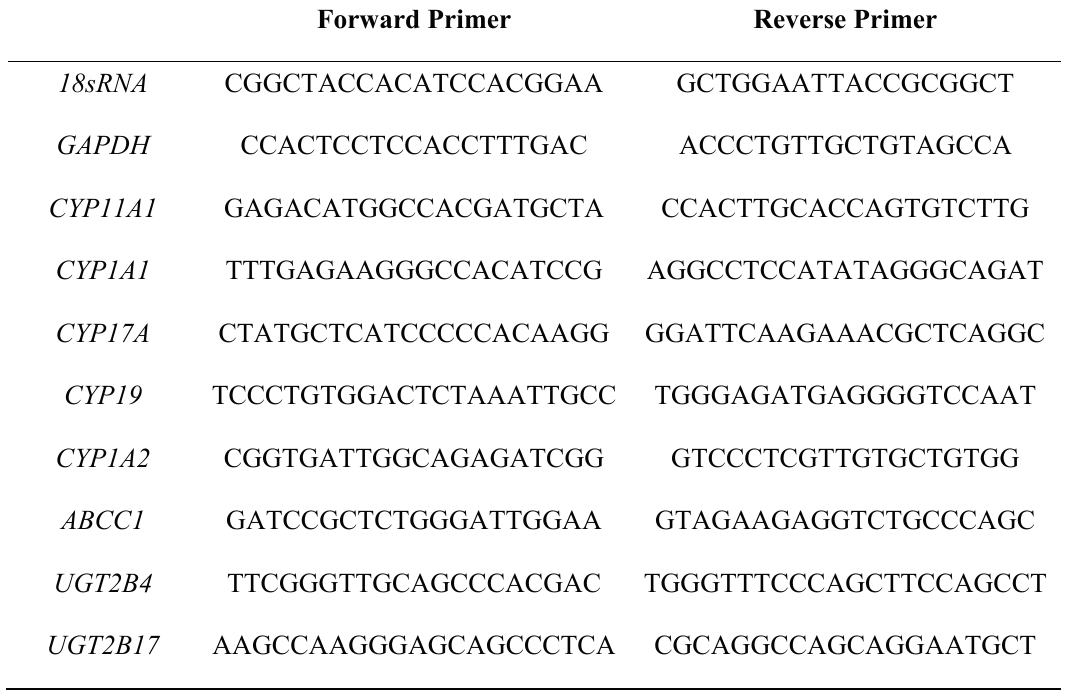
Table 1. Sequences of primers used for RT-PCR analysis. Amplification was performed as follows: 10 min 95 °C, 40 cycles: 10 s 95 °C, 15 s 60 °C, 20 s 72 °C Melting curves were recorded to control for identity and